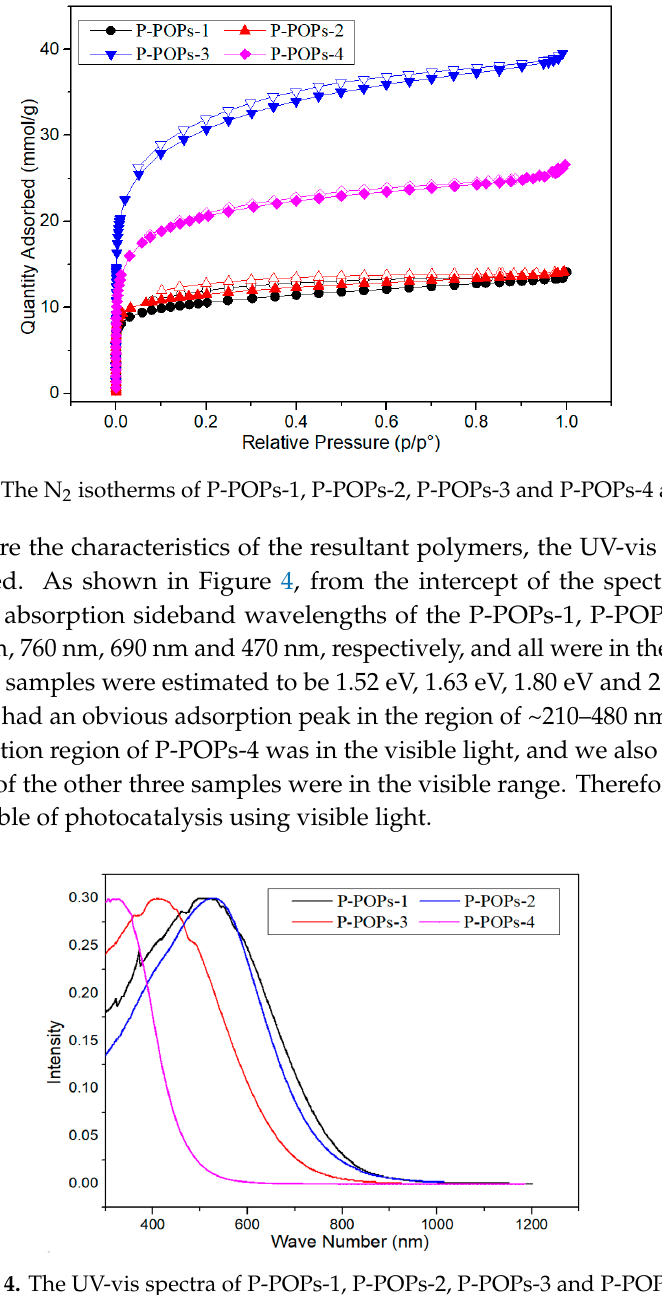
Figure 4. The UV-vis spectra of P-POPs-1, P-POPs-2, P-POPs-3 and P-POPs-4.